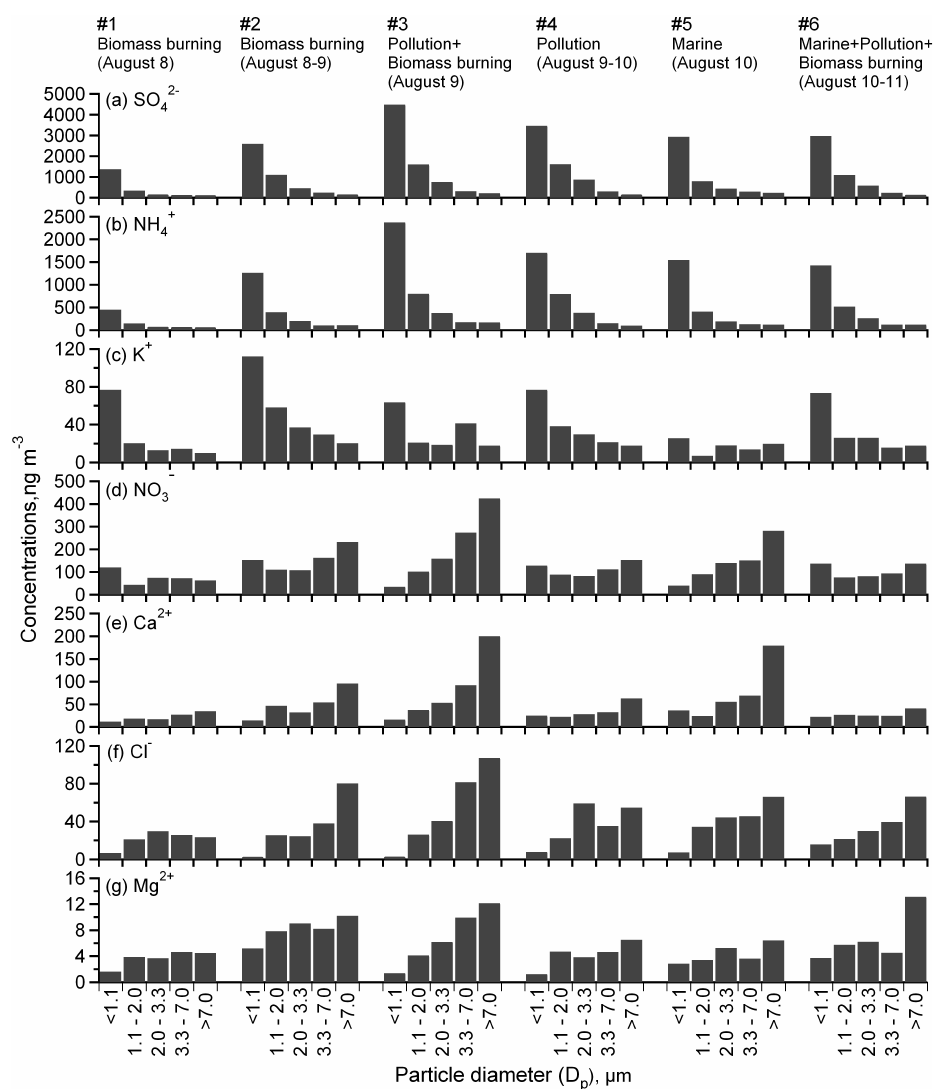
Fig. 8. Size distributions of individual inorganic ions in the Sapporo aerosols collected in summer 2005.